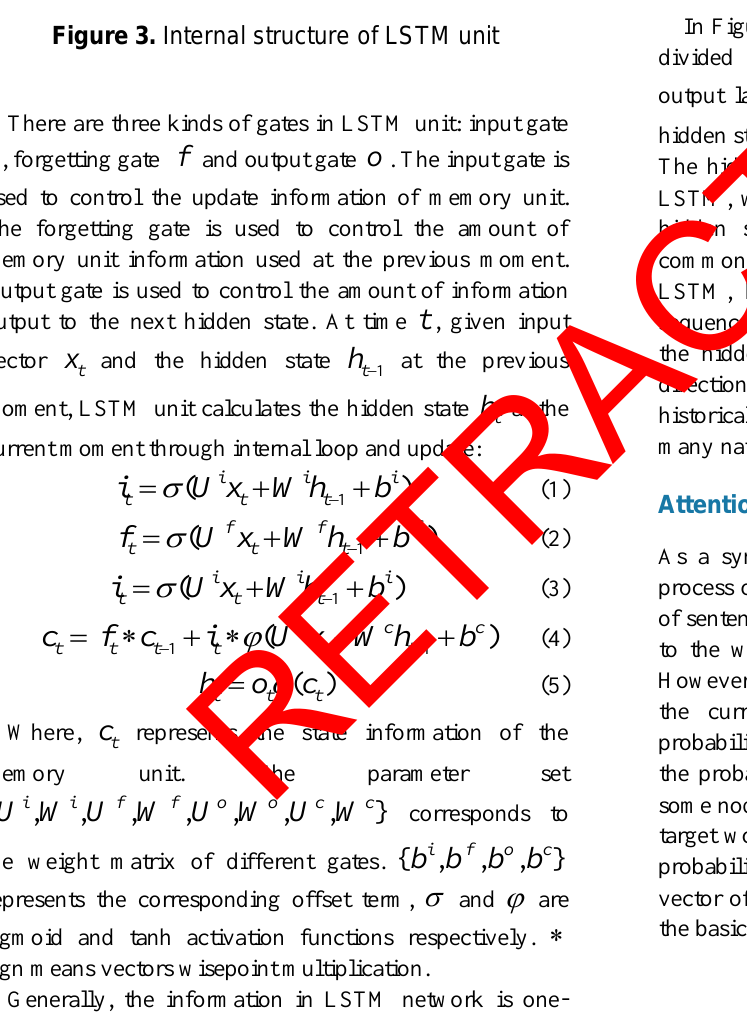
Figure 3. Internal structure of LSTM unit